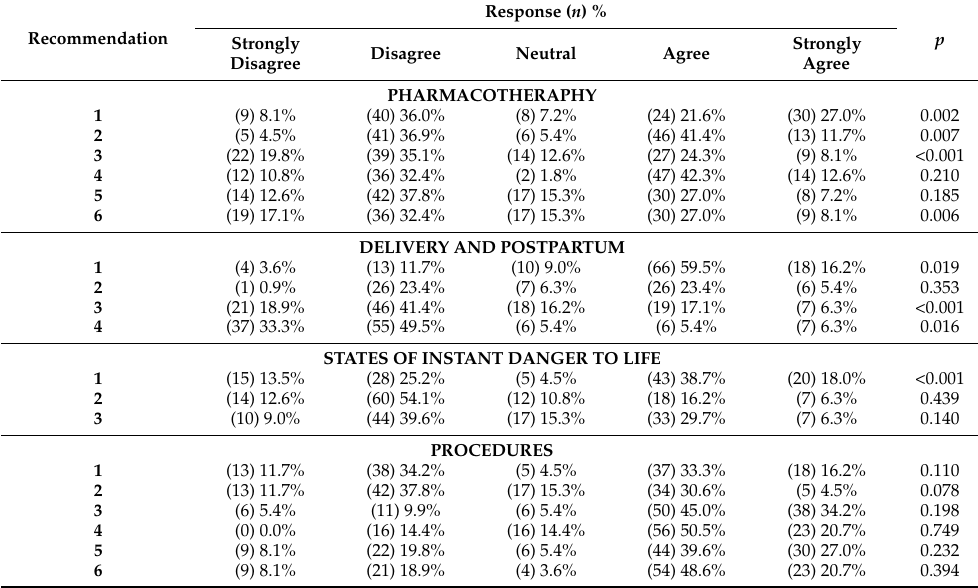
Table 2. Responses of the surveyed